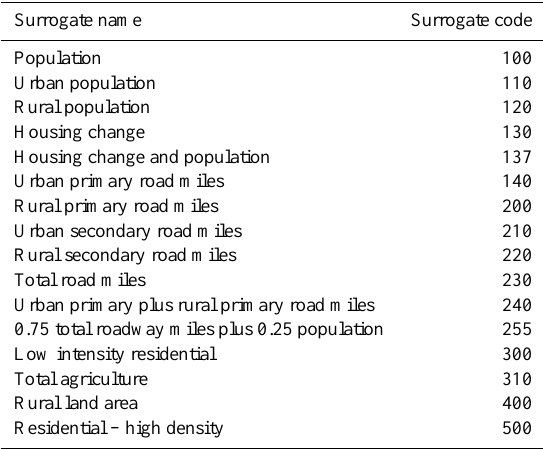
Table 2. ICLUS-based surrogates generated for 2005 and 2050. Table 3. Standard and sensitivity runs for ESP v2.0 demonstration and evaluation.